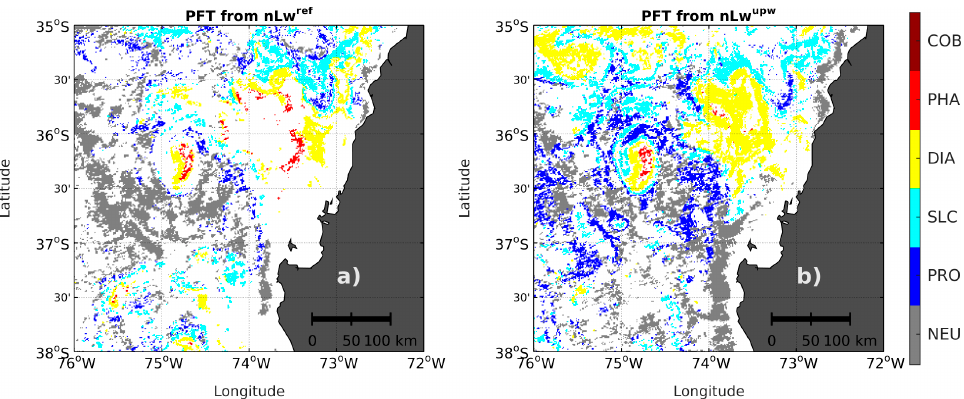
Figure 5. The PFT distribution calculated from a 3-day average of MODIS-A nLw data (4–6 February 2014), using: ( a ) the PHYSAT standard reference model (nLw ref ); and ( b ) the PHYSAT regional reference model (nLw upw ) for the coastal upwelling and transition zones in the region off central Chile.